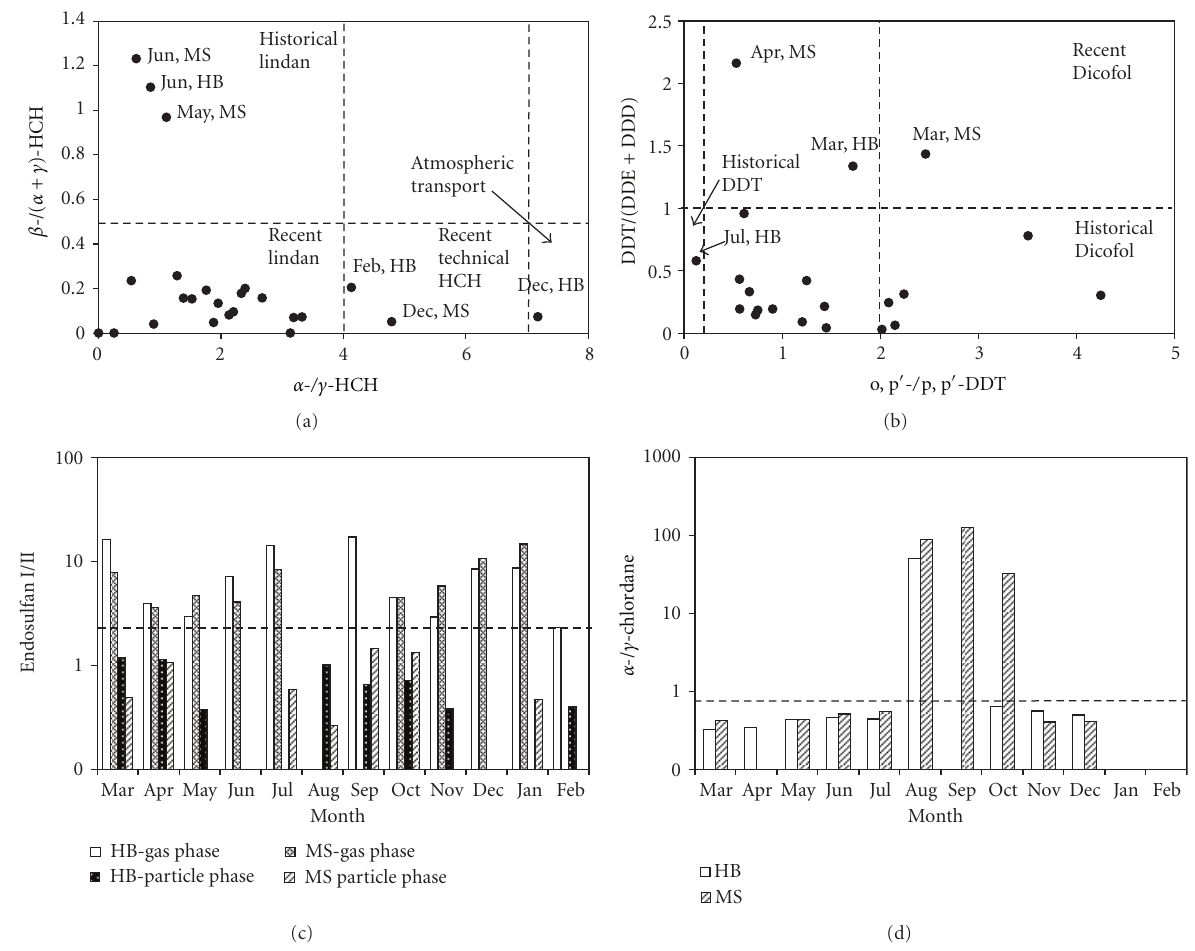
Figure 7: Source analyses of HCHs (a), DDTs (b), endosulfan (c), and chlordane (d) in ambient air at the HB sampling site and the MS sampling site from March 2010 to February